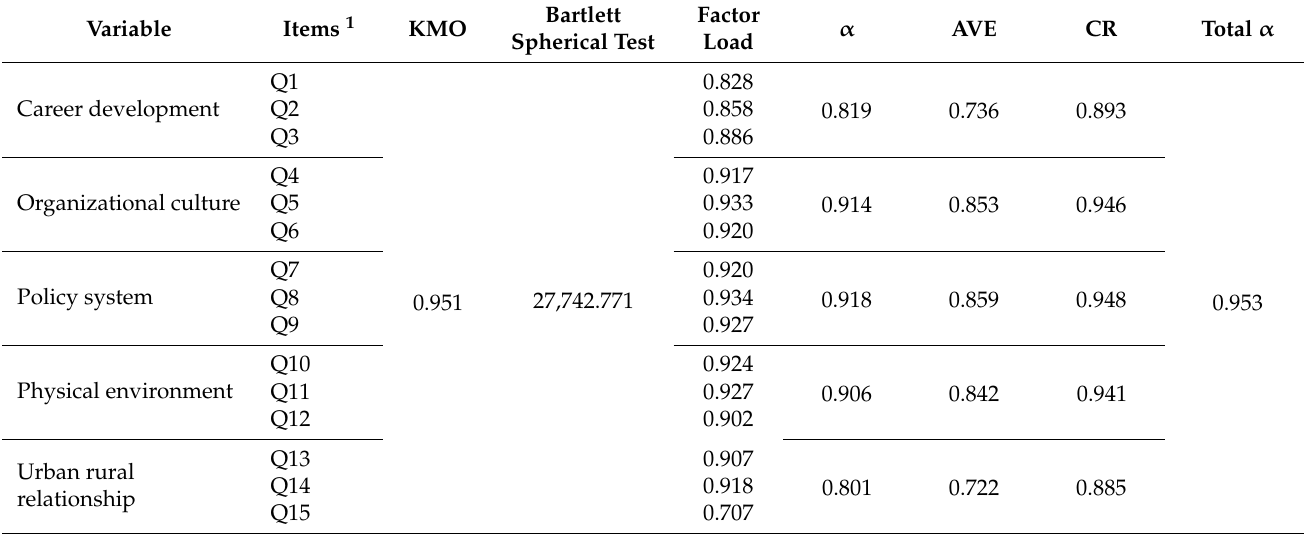
Table 2. The confirmatory factor analysis